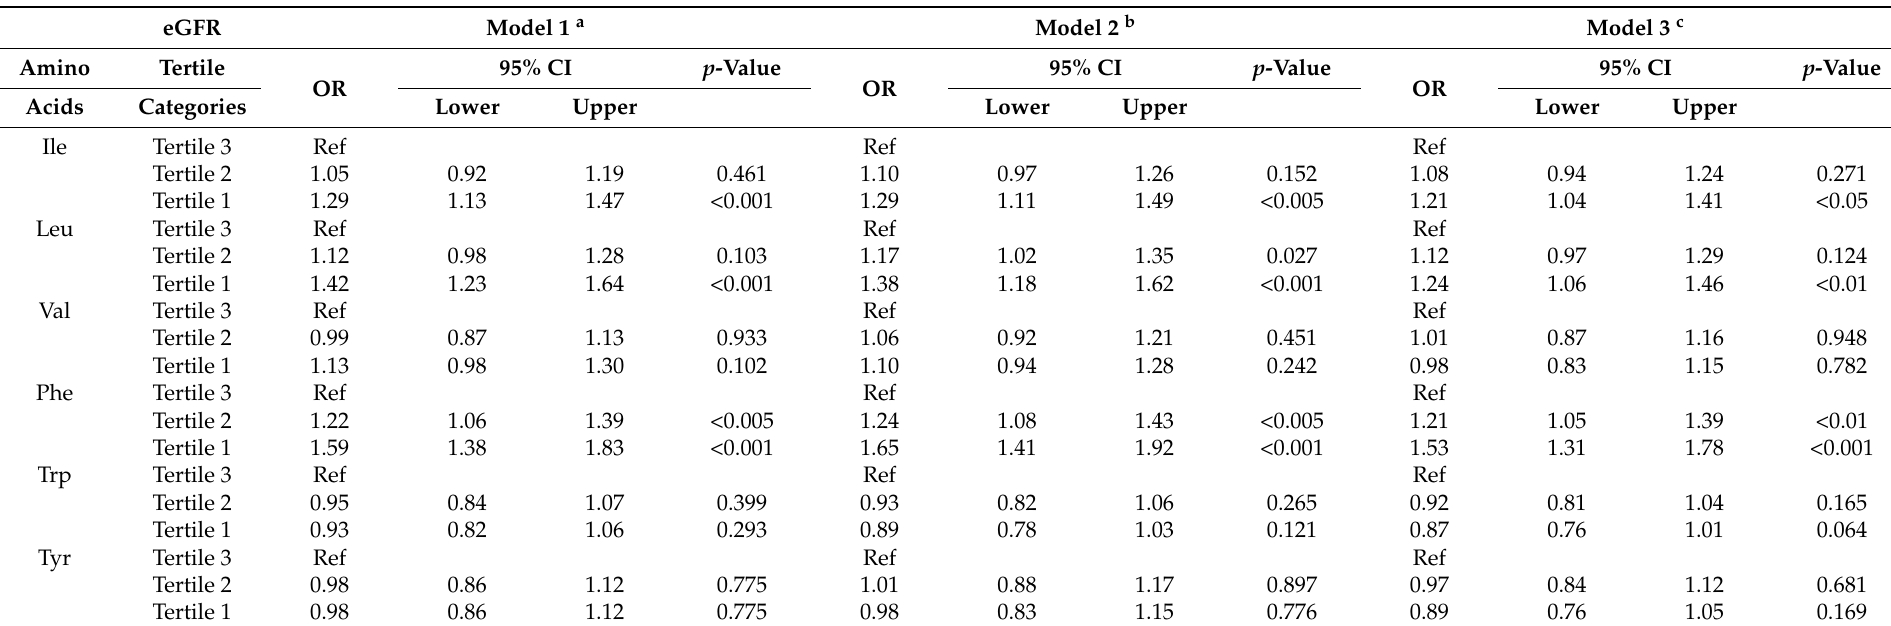
Table 4. Logistic regression analysis for association between BCAAs and AAAs with tertiles of